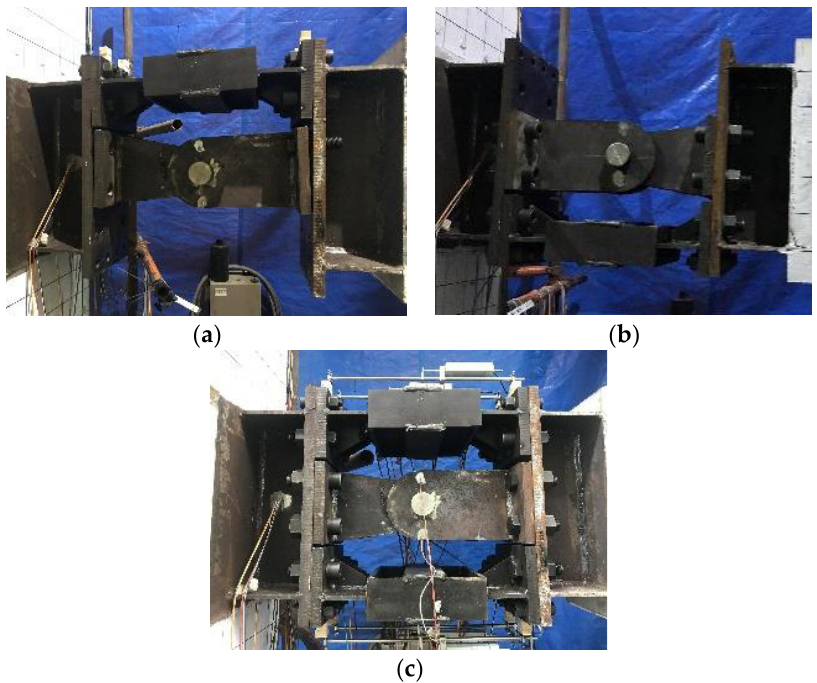
Figure 8. ( a ) Removing the lower restraint connector; ( b ) removing the upper connector; ( c ) com- pleted joint repair. joint